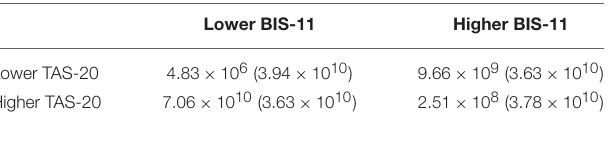
TABLE 5 | Means (and standard errors) of the total points scored for alexithymia by impulsivity.